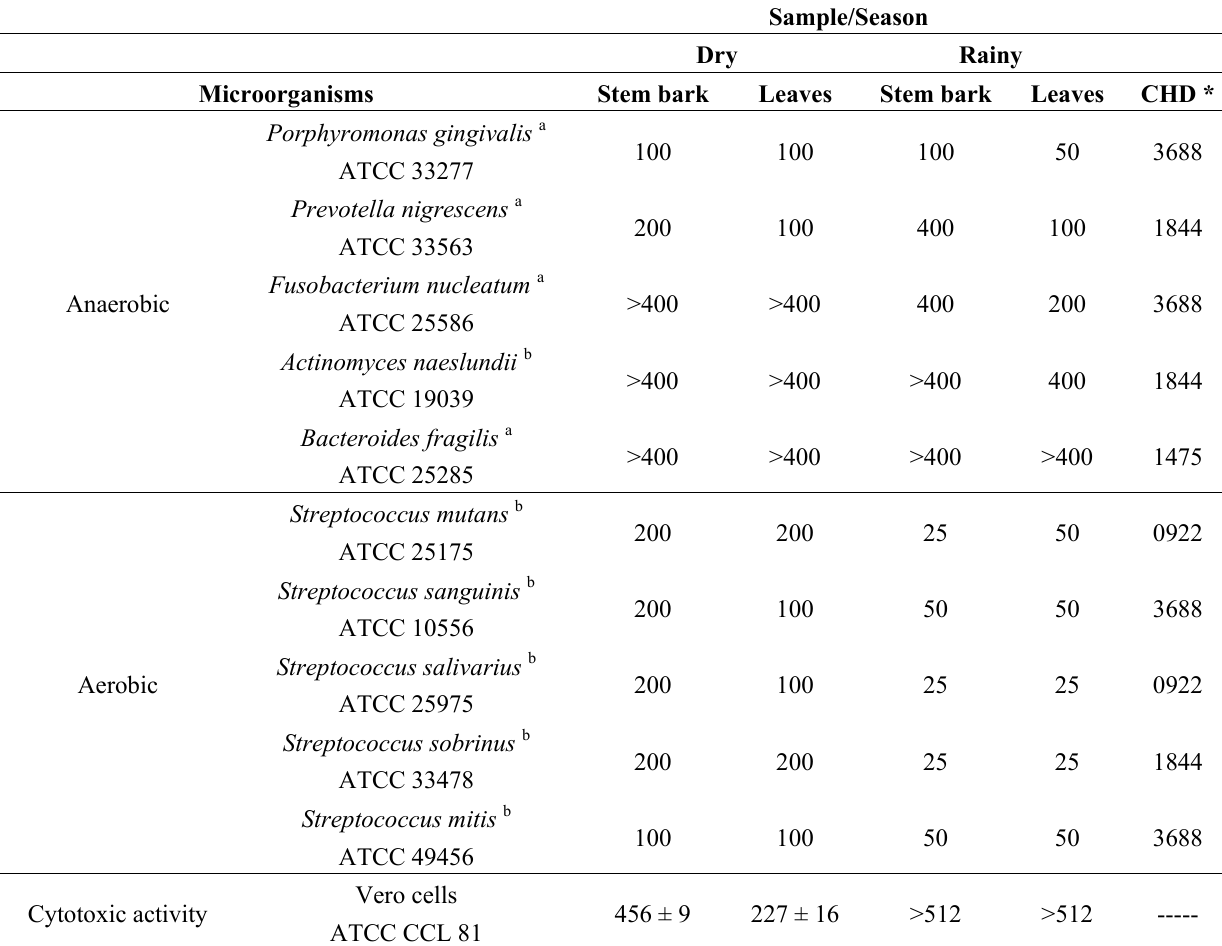
Table 5. Inhibitory effect on the growth of aerobic and anaerobic oral bacteria